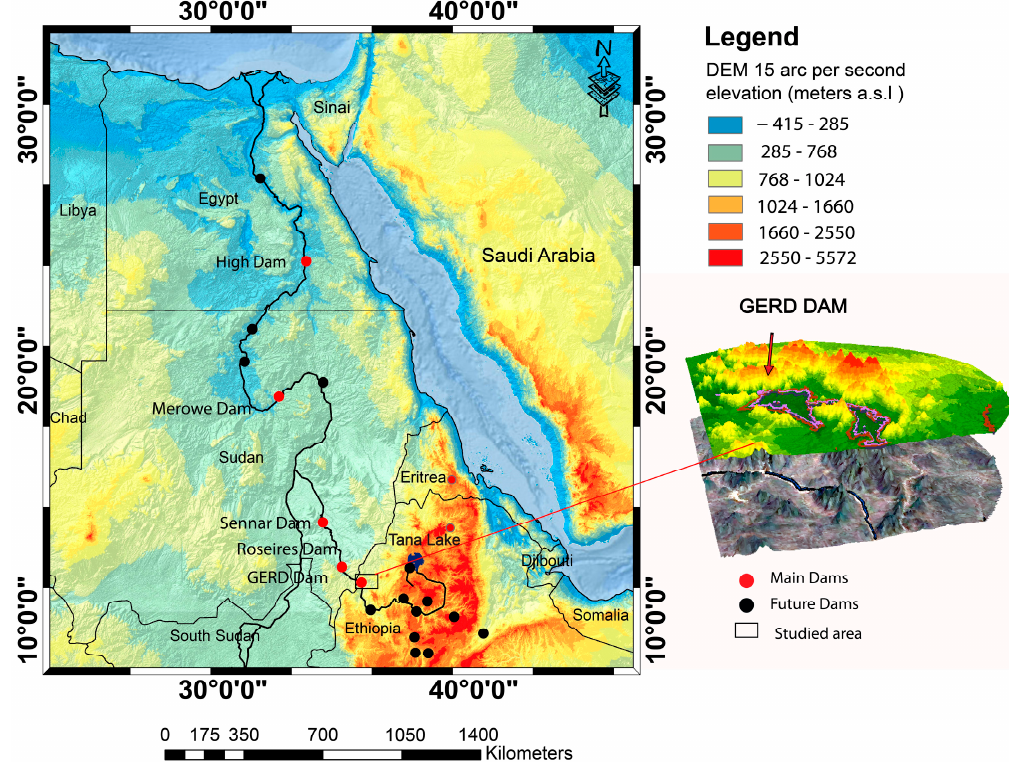
Figure 1. The location map of the studied area, which includes the location of the main artificial and proposed future dams in Africa. Data sourced from Wheeler et al. proposed future dams in Africa. Data sourced from Wheeler et al. [13].